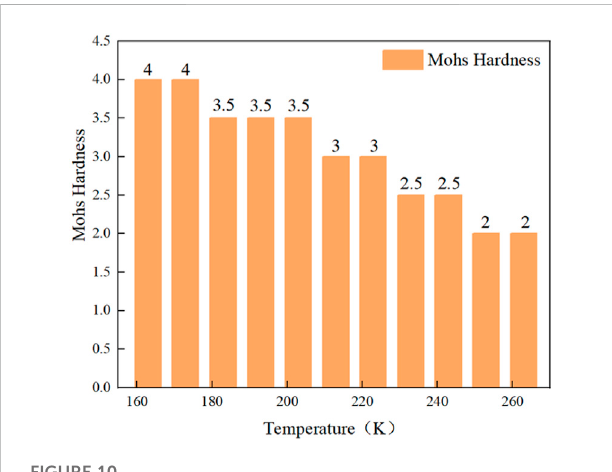
FIGURE 10 Mohs hardness of ice at different temperatures.